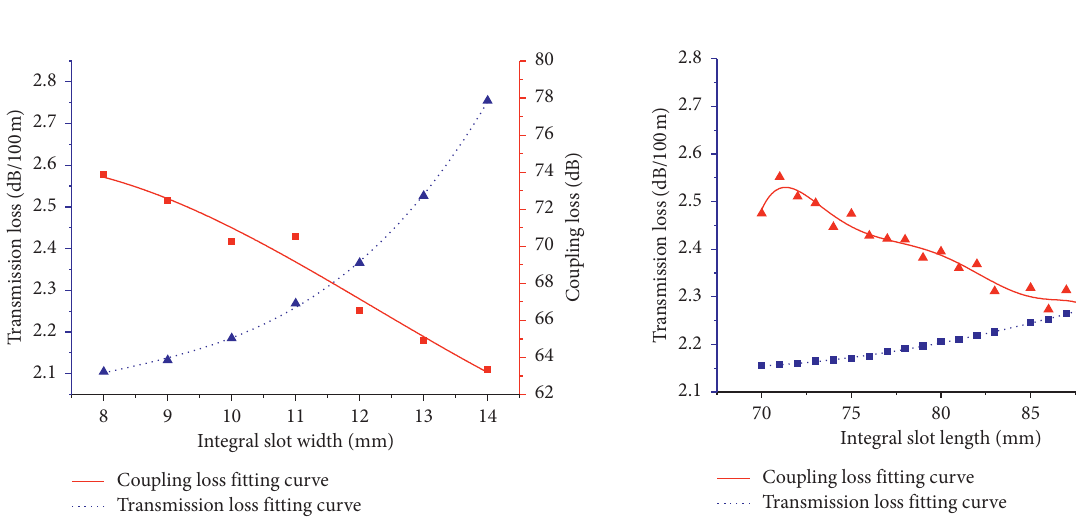
Figure 5: The relation between the width of U-groove in the vertical axial direction and the loss of leakage cable.